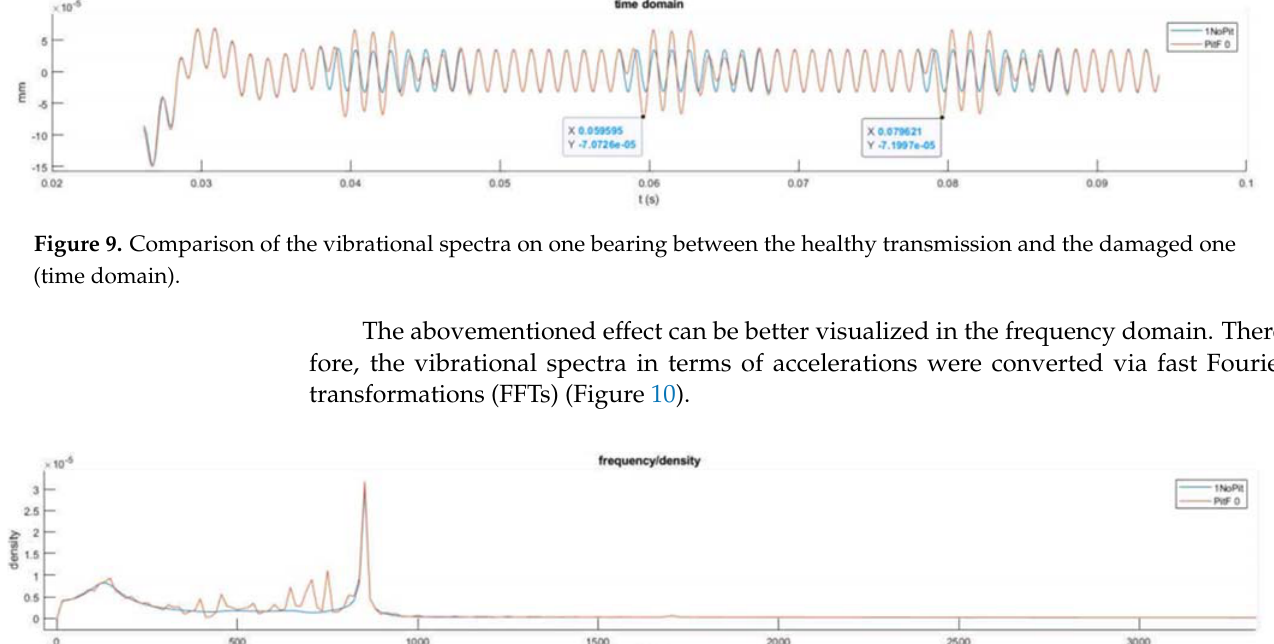
Figure 10. Comparison of the vibrational spectra on one bearing between the healthy transmission and the damaged one (frequency domain).